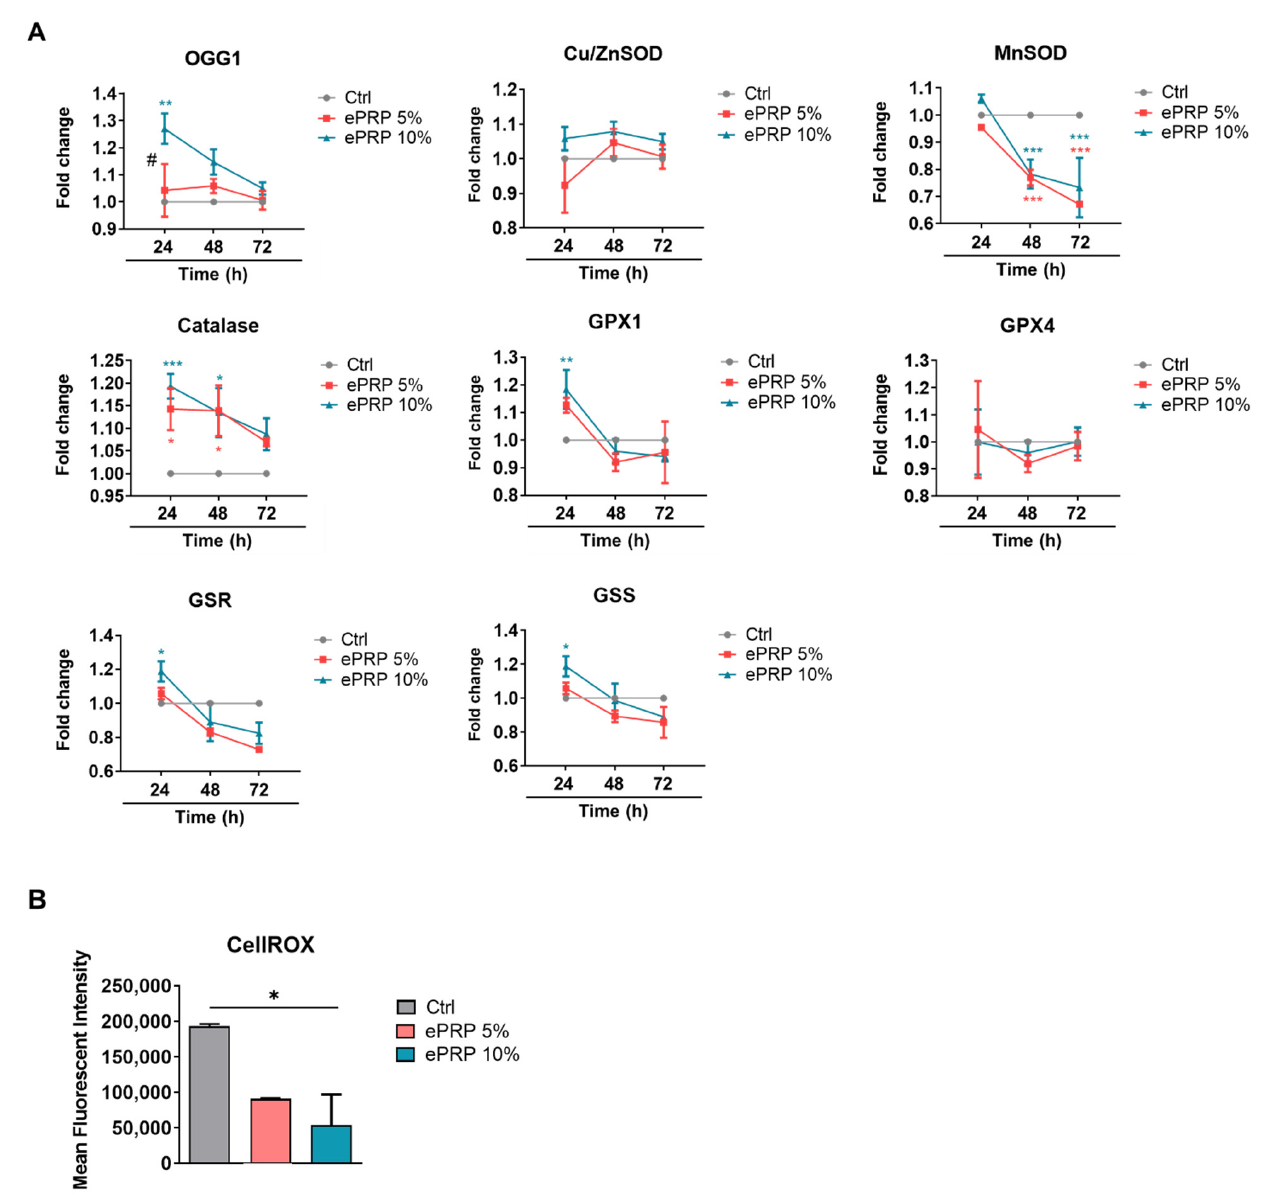
Figure 5. ePRP elevates antioxidant activity and reduces oxidative stress. ( A ) The relative mRNA level of antioxidant enzymes was measured in the absence of PRP or after pretreatment with 5% and 10% ePRP for 24 h, using EEF1A1 as an internal control gene. The experimental groups were expressed relative to the control group (baseline). The data are shown as mean ± SEM (N = 5). Two-way ANOVA with Tukey’s multiple comparisons test was used to verify statistical significance (* p < 0.05, ** p < 0.01, *** p < 0.001). * illustrates the statistical difference between each group; # shows the statistical difference between 24 and 48 h. ( B ) CellROX green was used to identify intracellular ROS following ePRP therapy and vehicle control. The ROS levels of mean fluorescence intensity (MFI) in untreated and ePRP-treated fibroblasts were compared using an ordinary one-way ANOVA, and the results were shown as means ± SEM (N = 2, * p <